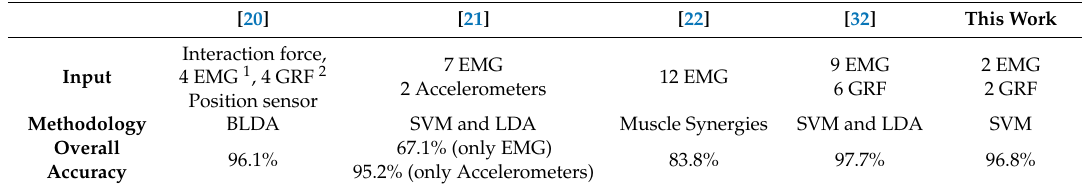
Table 7. Comparisons of classification accuracy with existing work utilizing EMG